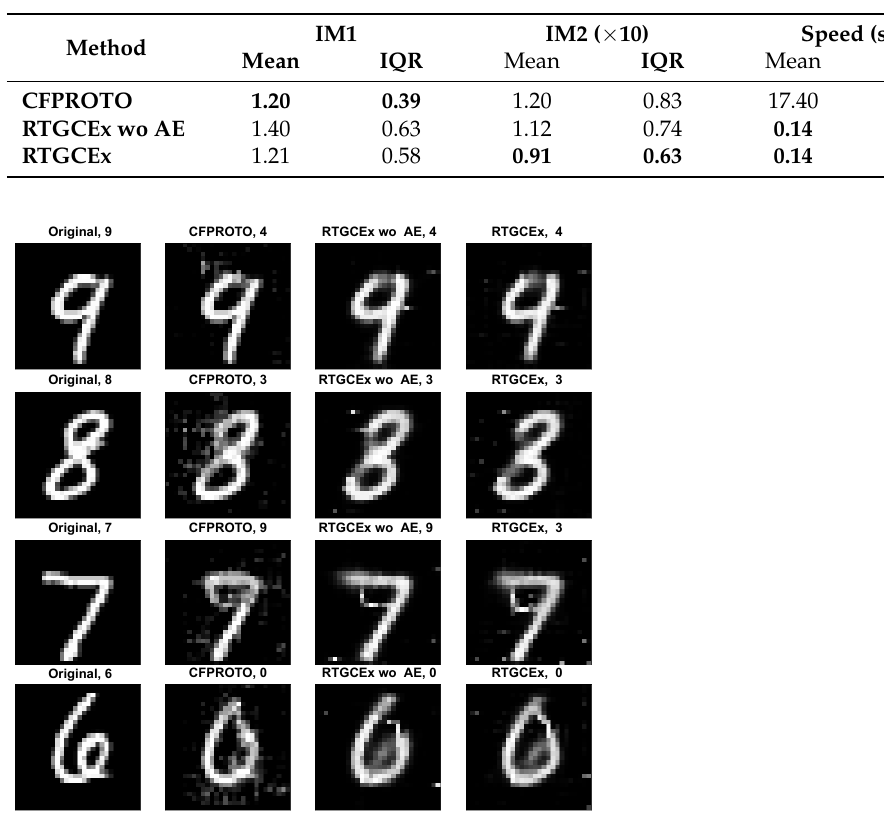
Table 2. Summary of the results obtained in test for each method. Best results are highlighted in bold.